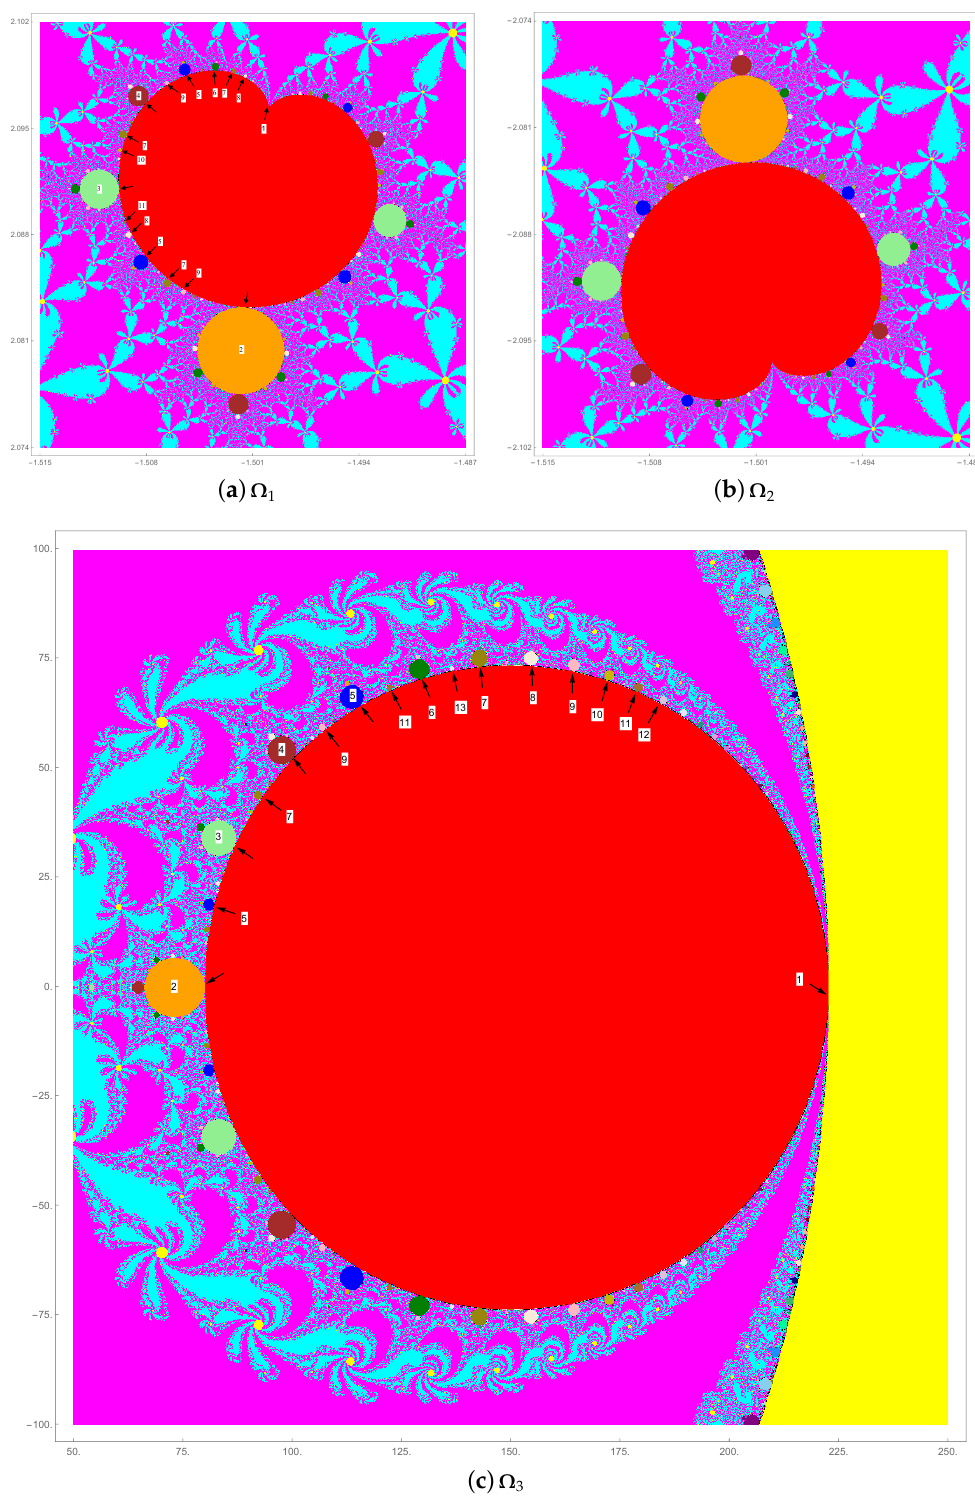
Figure 2. The three red fixed components Ω